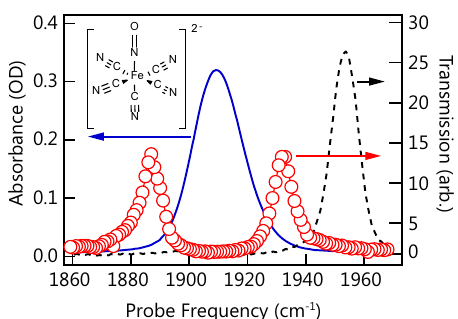
Fig. 1 Molecular structure and static spectra of SNP. The blue trace (left axis) is an absorption spectrum of SNP in MeOH in a CaF 2 transmission cell. The red trace (right axis) is the static transmission of the ultrafast infrared probe pulse through a 25 μ m Fabry – Pérot cavity tuned to resonance with the NO stretching band. Open circles represent the pixel spacing of the detector. The black trace (right axis) is the transmission of the same cavity when the cavity mode is detuned from resonance with the NO stretching band. Inset is schematic of the SNP